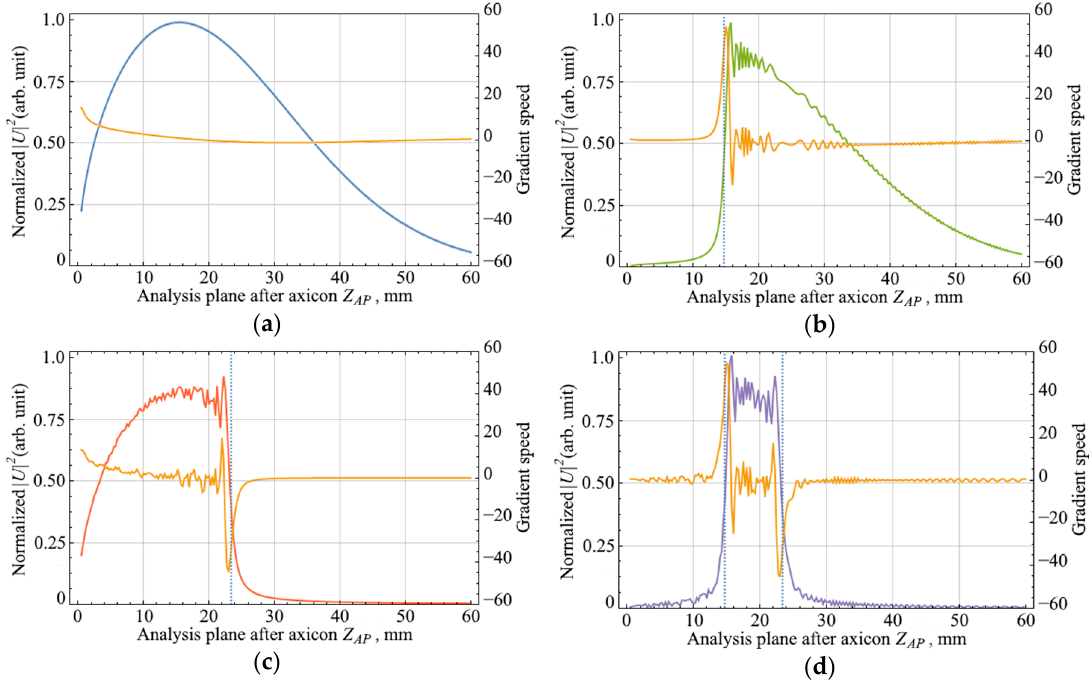
Figure 2. Axial intensity distributions of a Bessel beam and the gradient from the longitudinal coordinate z for various parameters of the mask before the axicon: ( a ) without binary mask, d = 0 mm, D → ∞ ; ( b ) with binary mask, d = 4 mm, D → ∞ ; ( c ) with binary mask, d = 0, D = 7 mm; ( d ) with binary mask, d = 4, D = 7 mm.